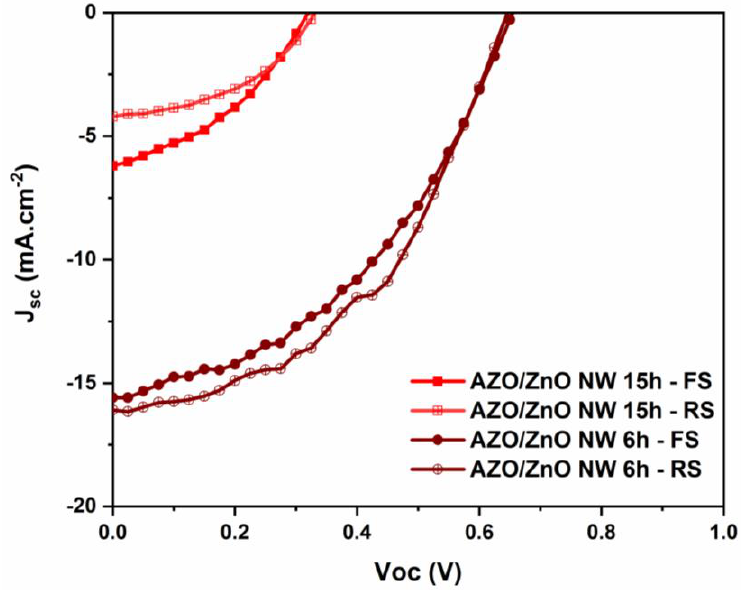
Figure 2. J – V characteristics under 1 sun of perovskite solar cells (best device) based on ZnO NW arrays grown on AZO for 6h and 15h, respectively. Table 2. Photovoltaic parameters of perovskite solar cells fabricated as a function of ZnO NW array growing time. The concentration of Zn(NO 3 ) 2 precursor solution was 50 mM, and the Zn(NO 3 ) 2 to HMTA and PEI ratios were defined as [Zn 2+ ]/[HMTA] = 1 and [Zn 2+ ]/[PEI] = 300. Growing